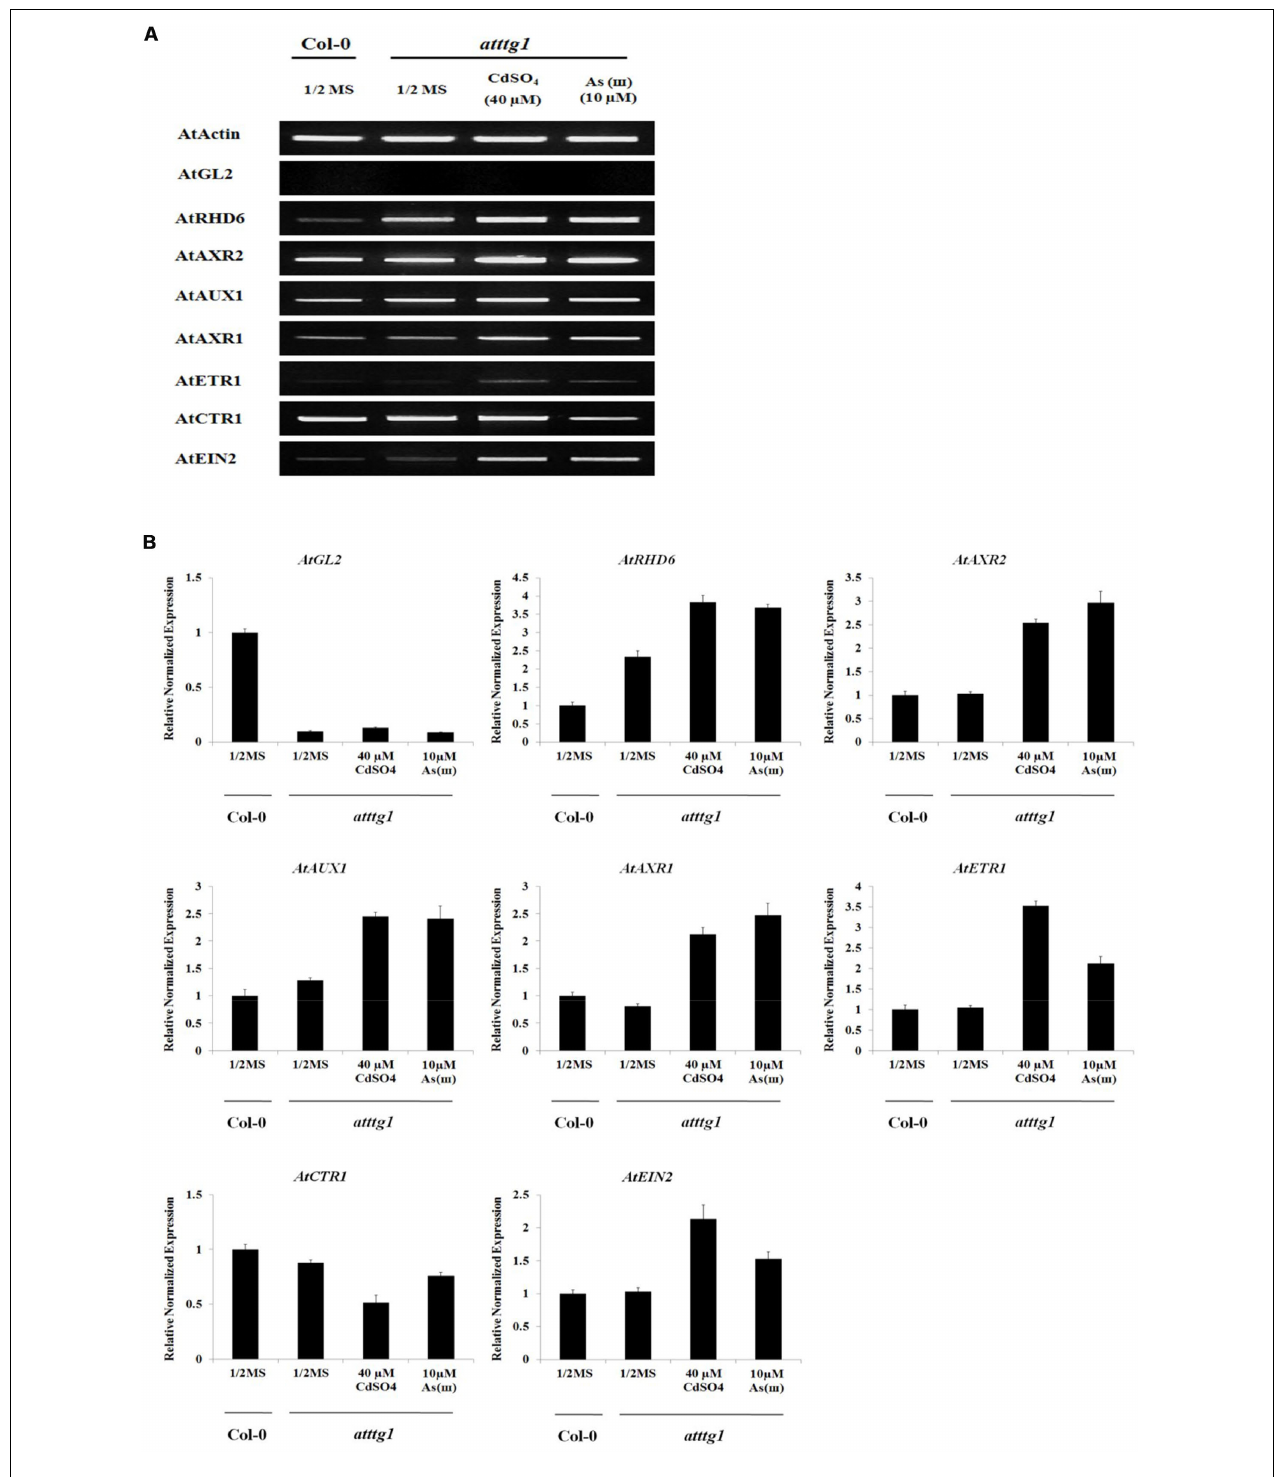
FIGURE 6 | Effect of Cd and As(III) on expressions of genes participated in the differentiation (fate determination) and elongation of root hairs in ttg1 Arabidopsis . (A) Semi-quantitative RT-PCR results showing relative transcript levels of various genes involved in the differentiation ( GL2 ), initiation ( RHD6 and AXR2 ) and elongation ( AUX1 , AXR1 , ETR1, CTR1, and EIN2 ) of root hairs in Col-0 and ttg1 Arabidopsis . RT-PCR was performed using total RNA isolated from 1-week old plants which were germinated and grown on 1/2 MS agar media treated with no metal, 40 µ M CdSO 4 and 10 µ M As(III). The gel photography represents three experimental replicates. (B) Quantitative real-time PCR results of various genes involved in root hair differentiation and elongation shown in (A) . Transcript levels were normalized to the transcript level of Actin .